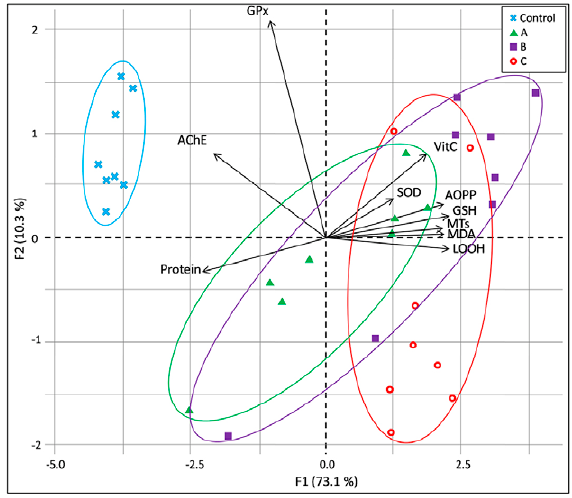
Fig. 2. – Principal component analysis (PCA) represented by two factors (F1=73.1% and F2=10.3%) and produced by biochemical variables (MDA, LOOH, AOPP, GPx, SOD, GSH, vit C, MT and AChE) in Mactra stultorum gills of control and specimens treated with graded doses (5, 10 and 20 mg L –1 ) of ACR for five